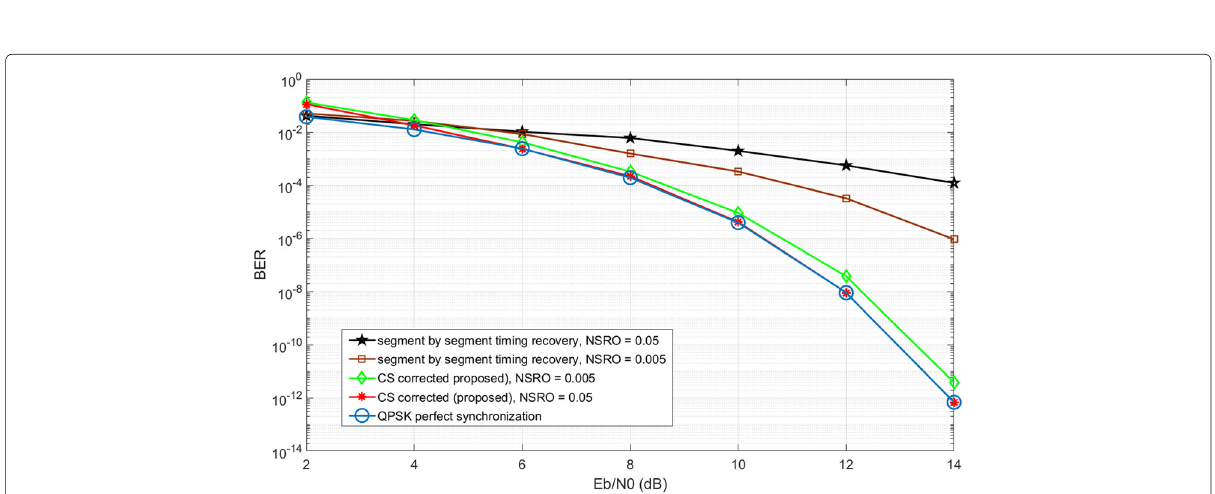
Fig. 9 BER performance of typical approach and introduced algorithm for η = 0.05 and η = 0.005, N (cid:2) = 4096, N = 300, modulation